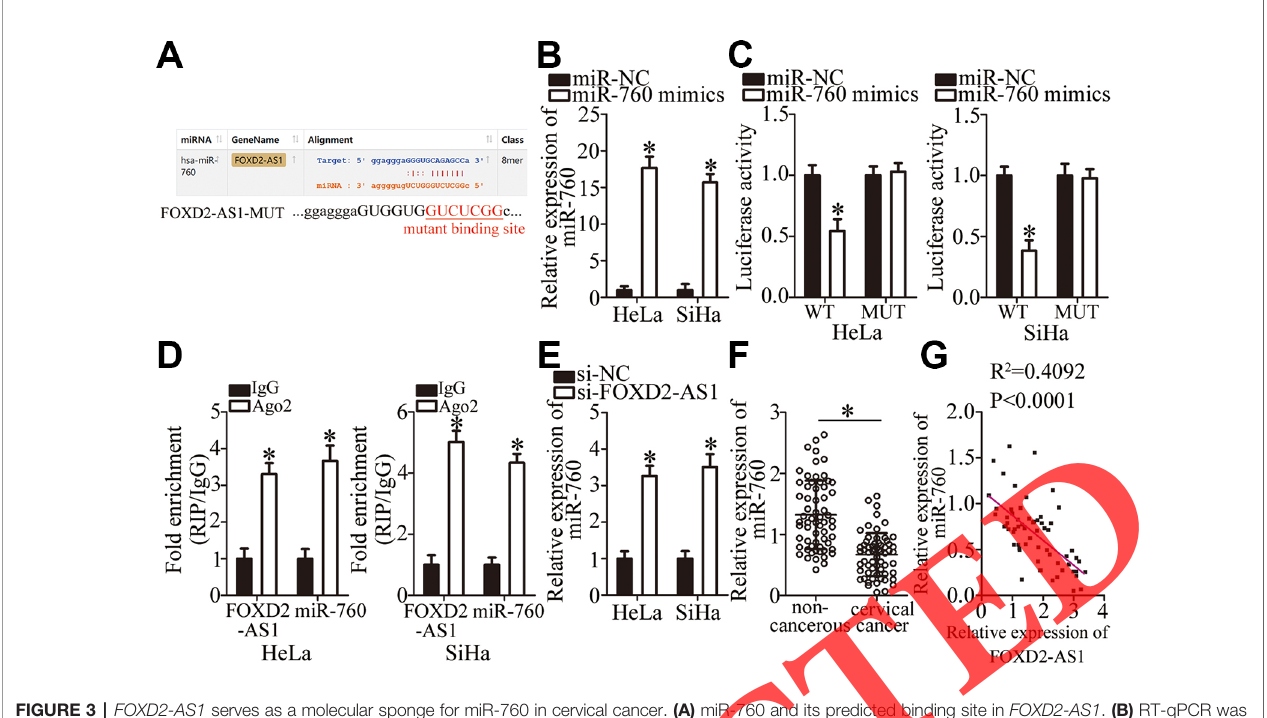
FIGURE 3 | FOXD2-AS1 serves as a molecular sponge for miR-760 in cervical cancer. (A) miR-760 and its predicted binding site in FOXD2-AS1 . (B) RT-qPCR was carried out to determine the transfection ef fi ciency of the miR-760 mimic in HeLa and SiHa cells. *P < 0.05 vs the miR-NC group. (C) Relative luciferase activity analyses in HeLa and SiHa cells cotransfected with either FOXD2-AS1-WT or FOXD2-AS1-MUT and either the miR-760 mimic or miR-NC. *P < 0.05 vs the miR-NC group. (D) The RIP assay indicated that both FOXD2-AS1 and miR-760 were immunoprecipitated by the anti-AGO2 antibody. *P < 0.05 vs the IgG group. (E) The expression of miR-760 was measured by RT-qPCR in HeLa and SiHa cells transfected with either si-FOXD2-AS1 or si-NC. *P < 0.05 vs the si-NC group. (F) RT- qPCR was carried out to quantify the miR-760 expression in 63 pairs of cervical cancer tissue samples and adjacent noncancerous tissue samples. *P < 0.05 vs noncancerous tissues. (G) The expression correlation between levels of FOXD2-AS1 and miR-760 was analyzed in cervical cancer tissues by Spearman ’ s correlation analysis. R 2 = 0.4092, P <